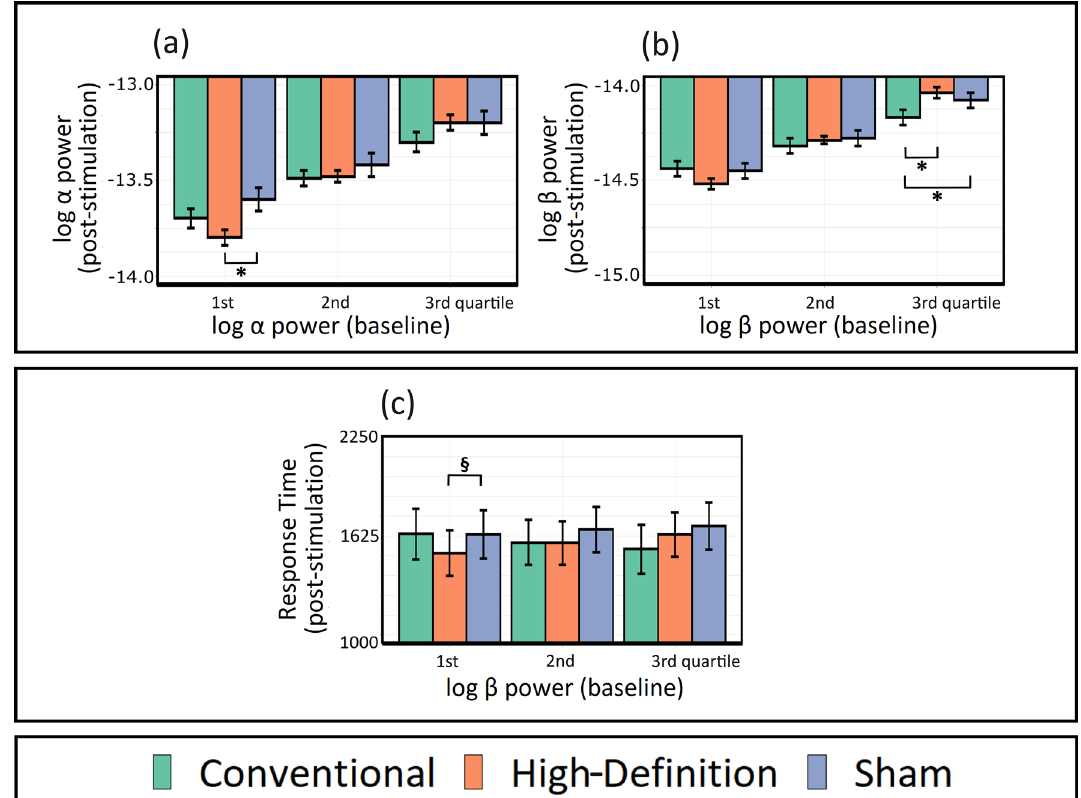
Figure 1. Neurophysiological and behavioural results. ( a ) Modulation of alpha power in the post-stimulation stage across stimulation conditions with alpha power at the baseline as covariate. In the x-axis, the 1st, 2nd, and 3rd quartile of the covariate, respectively − 14, − 13.5, − 13.2 power units, while in the y-axis, alpha power at the post-stimulation stage. At low levels of alpha power at the baseline (i.e., the 1st quartile), results show a significant reduction of alpha power in the post-stimulation stage only for HD-tDCS (red bar) relative to sham (blue bar). ( b ) Modulation of beta power in the post-stimulation stage across stimulation conditions with beta power at the baseline as covariate. The x-axis shows the 1st, 2nd, and 3rd quartile of the covariate, respectively − 14.6, − 14.3, − 13.9 power units, while the y-axis represents beta power at the post-stimulation stage. At high levels of beta power at the baseline (i.e., the 3rd quartile), a significant reduction of beta power in the post- stimulation stage was found only for Conventional tDCS (green bar) relative to both HD-tDCS and sham. ( c ) Response times (RTs) modulation across stimulation conditions with beta power at the baseline stage as covariate. In the x-axis, the 1st, 2nd, and 3rd quartile of the covariate, namely − 14.6, − 14.3, − 14 power units, while in the y-axis, RTs at the Finger Tapping Task performed during the post-stimulation stage. At low levels of beta power in the baseline stage (i.e., the 1st quartile), results show a reduction of RTs in HD-tDCS relative to sham. * p < 0.05; § p =